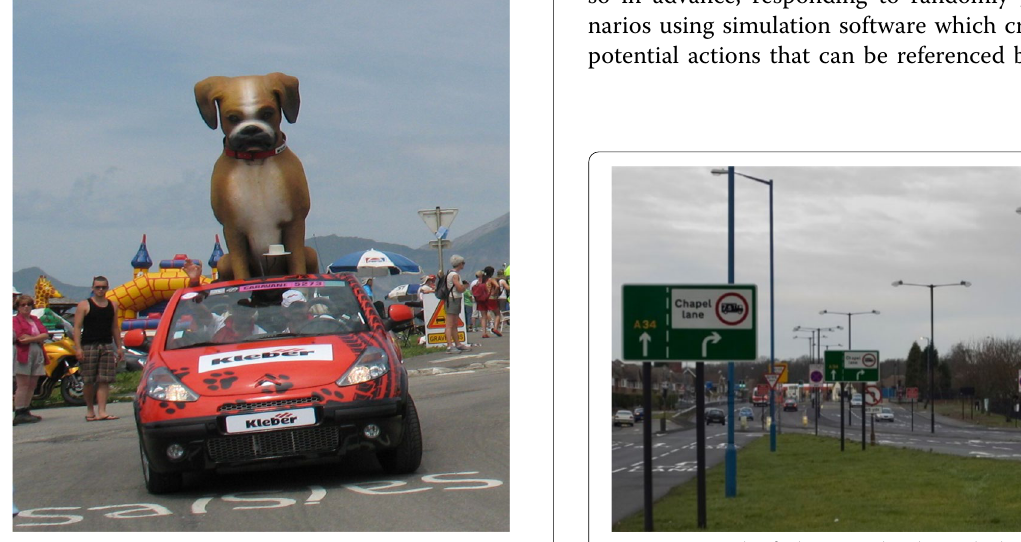
Fig. 2 An example of an edge case; a large model of a dog travelling on a car may be classified as an animal, but its behaviour (travelling at speed) may not correspond with system expectations. This Photo by Unknown Author is licensed under CC BY-SA